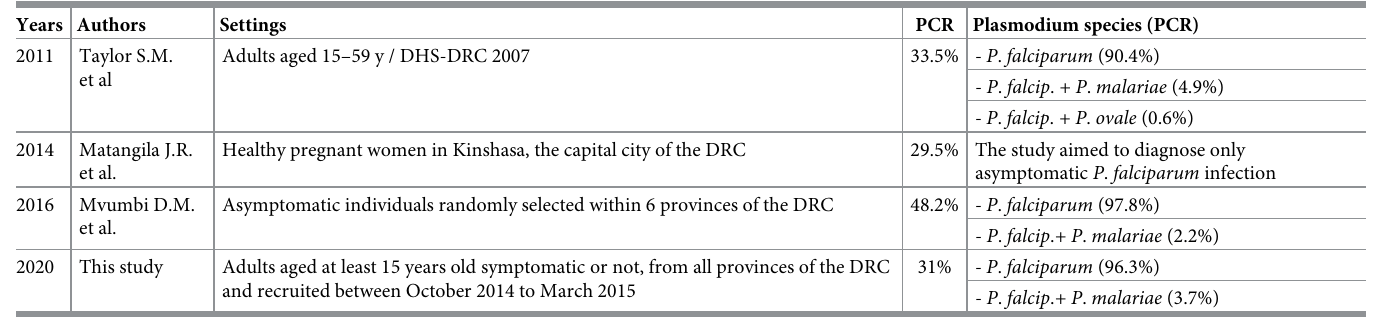
Table 6. Assessment of Plasmodium infection by PCR analysis in